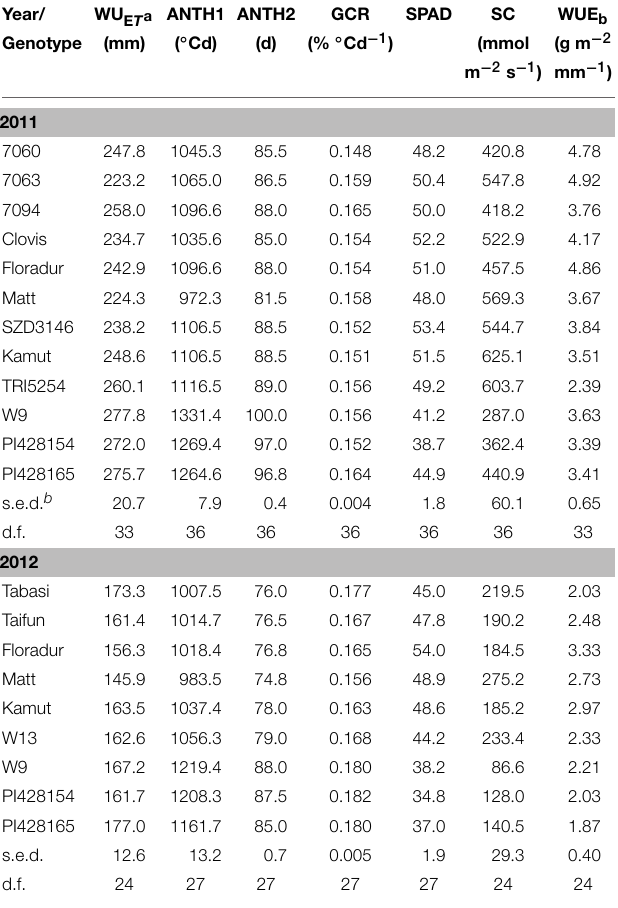
TABLE 3 | Genotypic mean values of phenological and physiological traits in 2011 and 2012.